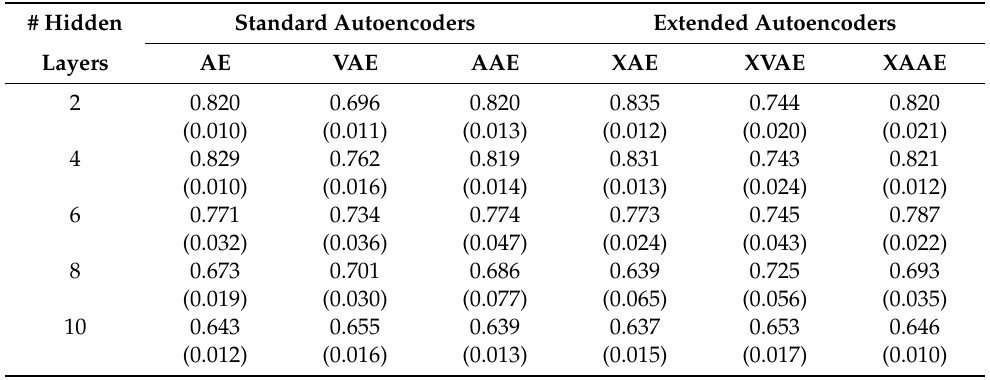
Table 3. AUROC with di ff erent number of hidden layers on MI-F dataset. The number of in parenthesis indicates the standard deviation.